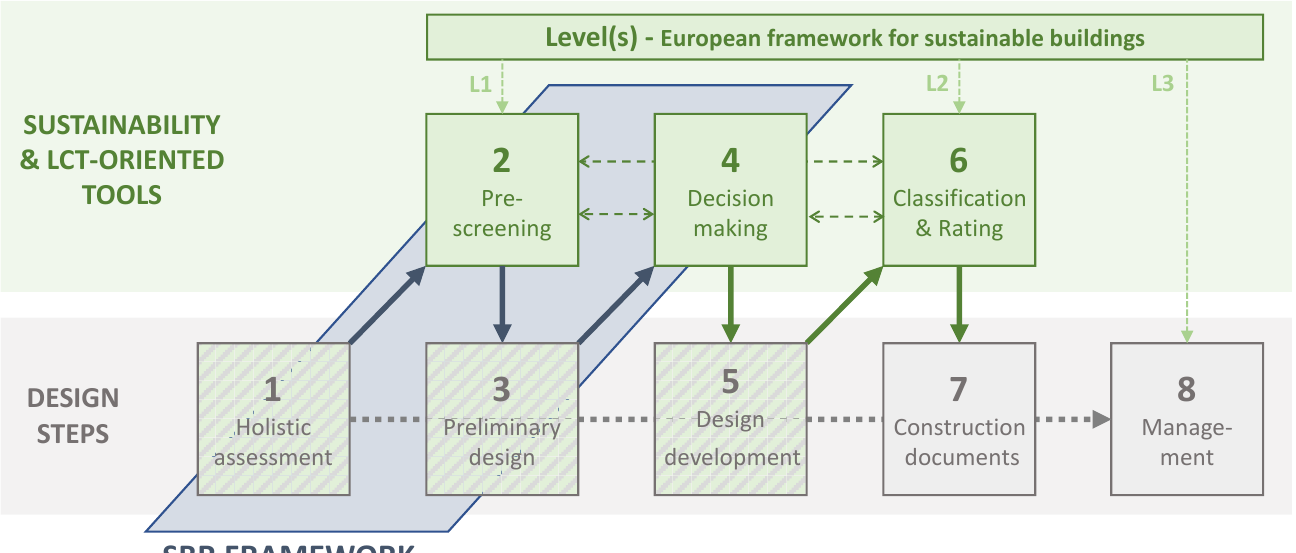
Figure 6. Visual representation of the workflow of a design procedure aimed at fostering the sustainability of the retrofitting intervention (steps 1 to 8) obtained by integrating SBR steps, sustainability and LCT-oriented tools, as well as Level(s) metrics and criteria, into the workflow of the traditional design procedure (commonly limited to steps 1, 3, 5, 7, 8).